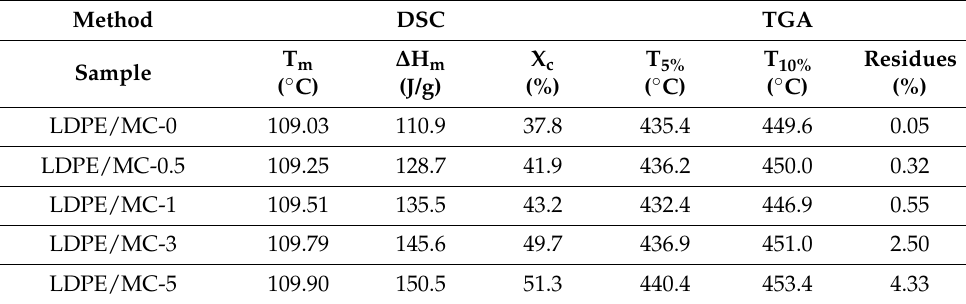
Table 1. Thermal properties of LDPE/MC composite films by TGA and DSC analyses.